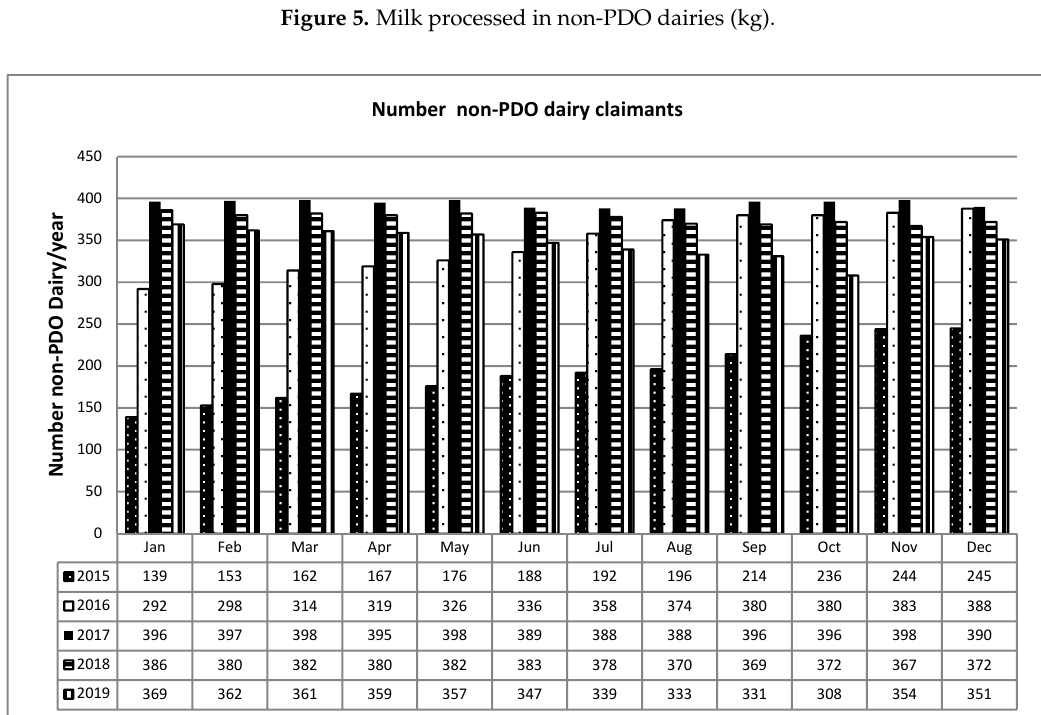
Figure 5. Milk processed in non-PDO dairies (kg).